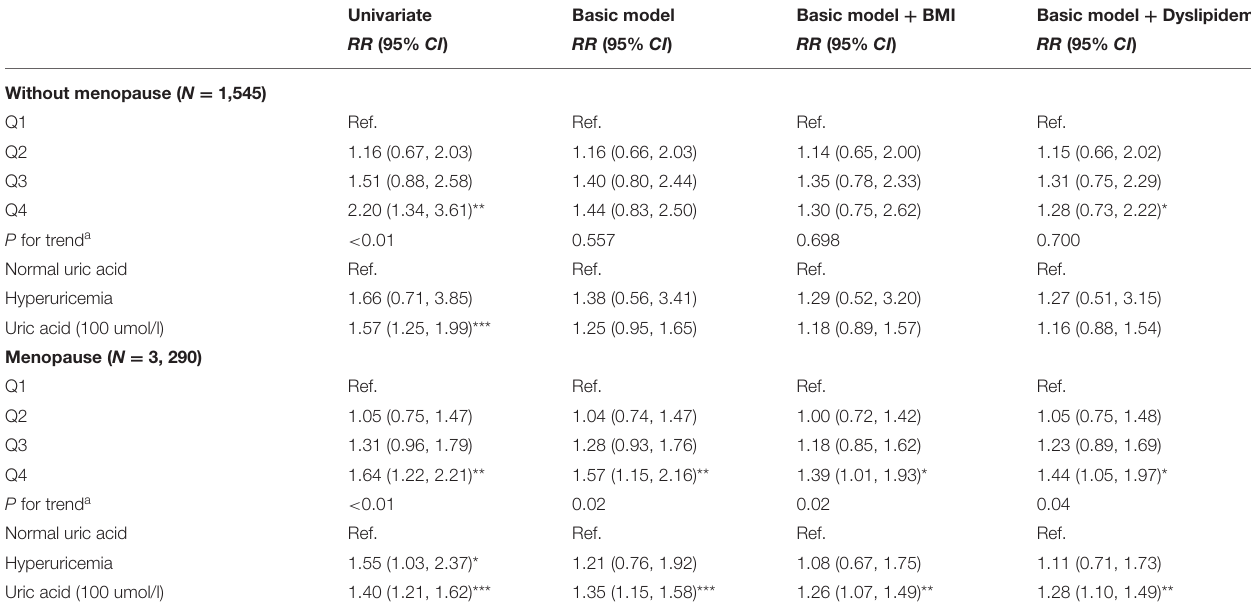
TABLE 3 | Risk ratios (95% confidence intervals) of diabetes according to SUA in women subgroup analysis.